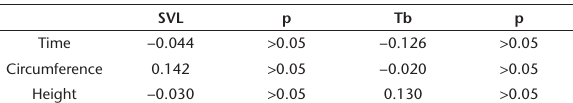
Table 5. Canonical relationship between two groups of variables: Tb (body temperature of Amphisbaena munoai ) and SVL (snout- vent length) × time, rock circumference, and rock height for the total study (n =